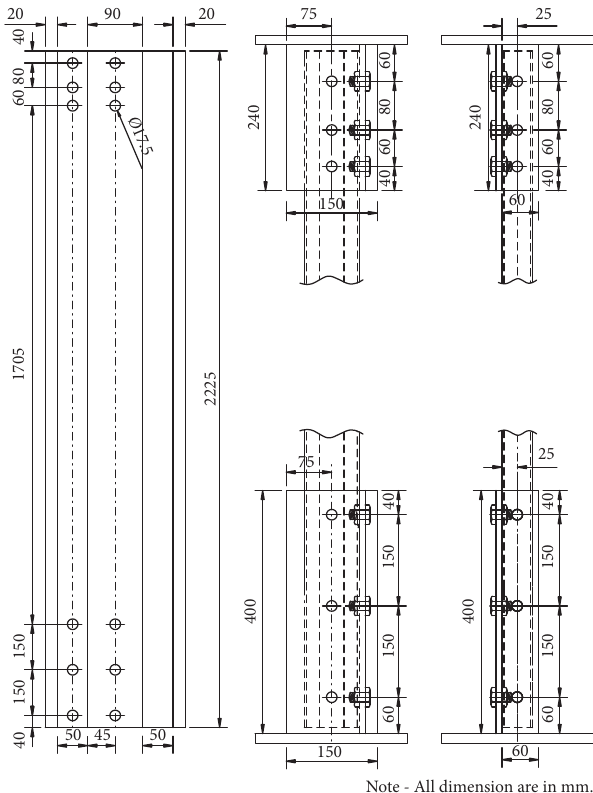
Figure 3: Fabrication details of the compression element and details of the end